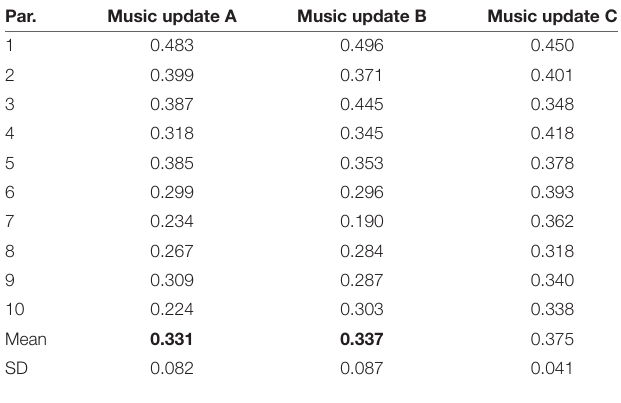
TABLE 5 | Distance between target and induced emotions: Bold indicates distance with a significant difference from baseline method. Par.